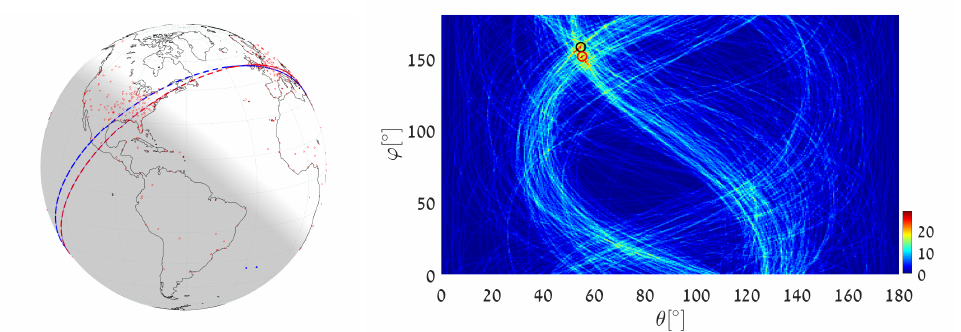
Figure 17. Executing Algorithm 1 on the airport database. ( Left ) The blue great circle passes through the maximum number of airports (red dots). The red great circle corresponds to the second maximum, following the unvoting process. ( Right ) Heat plot of the accumulator array M , showing the parameters of the two great